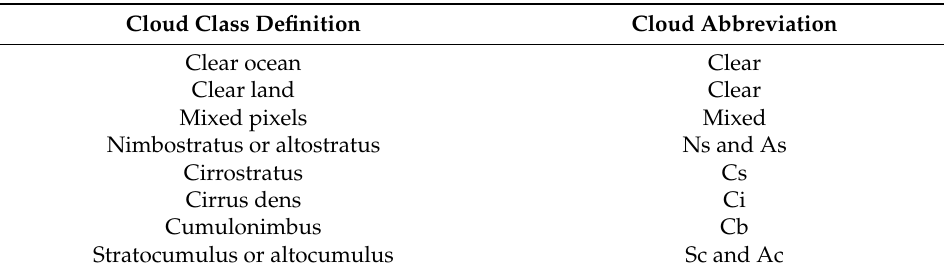
Table 3. Description of 2VISSR-II cloud classification products.